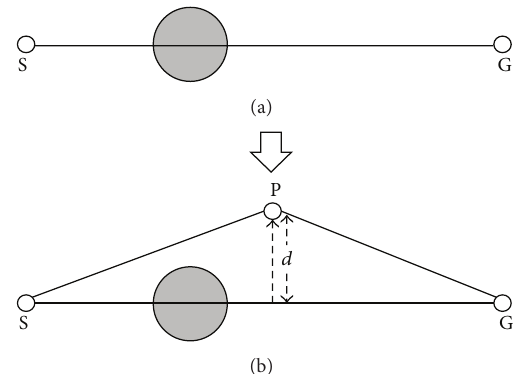
Figure 2: A simple example of creating a collision-free path.